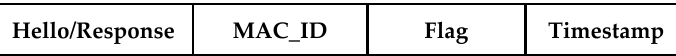
Figure 8. Format of Hello and Response packet.